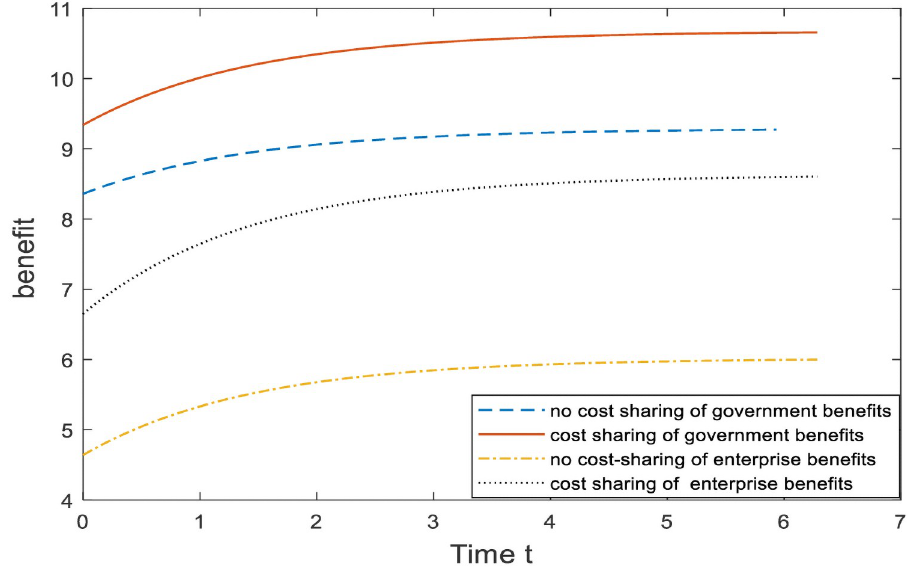
Fig 3. Comparison of government and enterprise